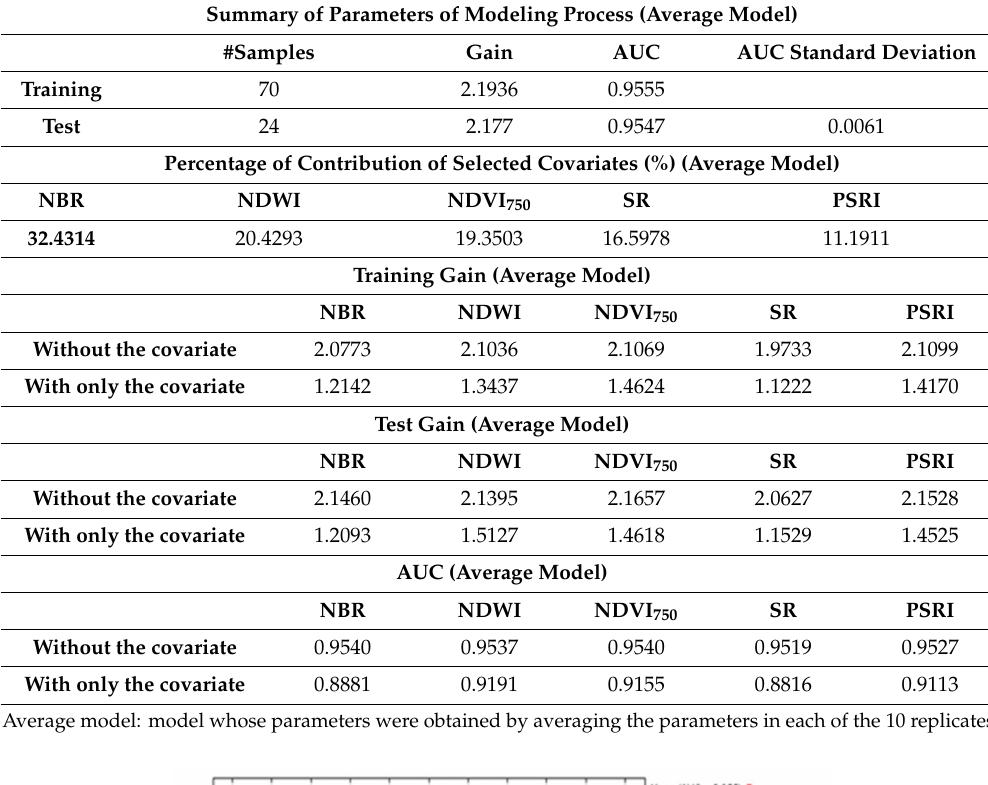
Table 1. Summary of parameters of modeling process.